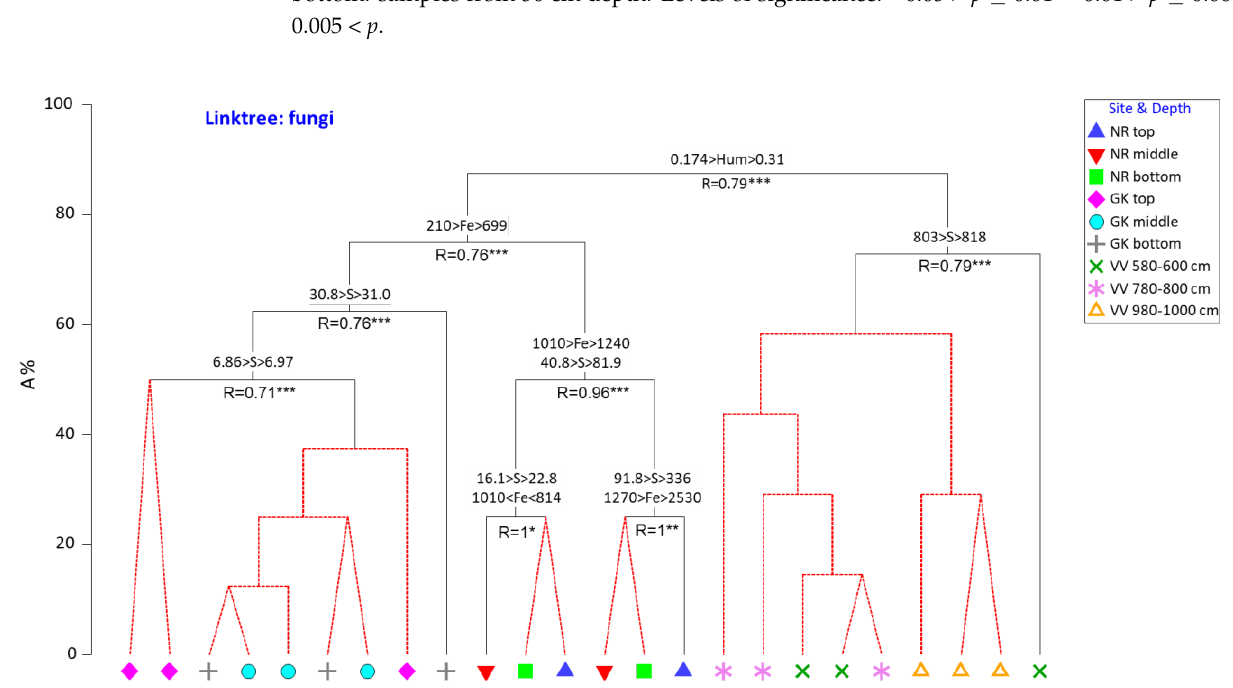
Figure 9. LINKTREE showing concentrations of the most important environmental parameters identified using BEST analysis selecting the actinobacterial community structure in the peat sam- ples. All concentrations are in mg/L. N is a proxy for C, S, and LOI (loss on ignition). NR = Nuwejaars River system (developing peatland); GK = Goukou River system (impacted peatland); VV = Vankervelsvlei (undisturbed peatland). Top: samples from 0 to 5 cm depth; middle: samples from 25 cm depth; bottom: samples from 50 cm depth. Levels of significance: * 0.05 > p ≥ 0.01 ** 0.01 > p ≥ 0.005 *** 0.005 < p .